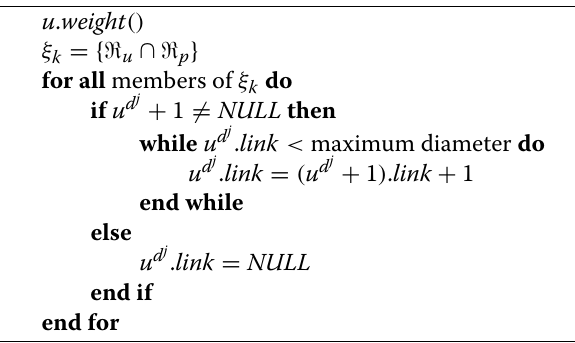
Algorithm 3 The weight procedure for node